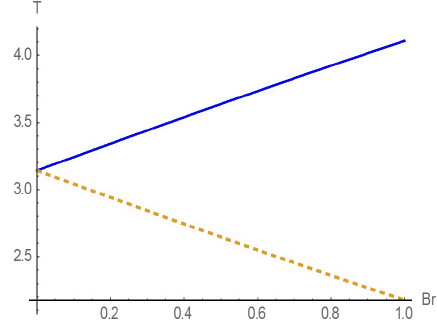
Figure 3. The probability density of the moving shoreline vertical displacement for the initially sine wave run-up at Br = 0 (the dotted line), 0.5 (the dashed line), and 1 (the solid line).